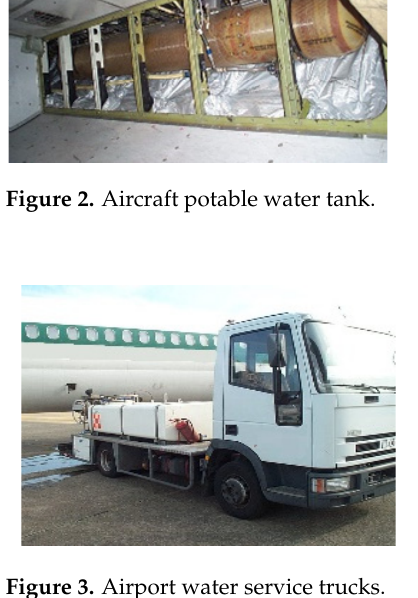
Figure 2. Aircraft potable water tank.